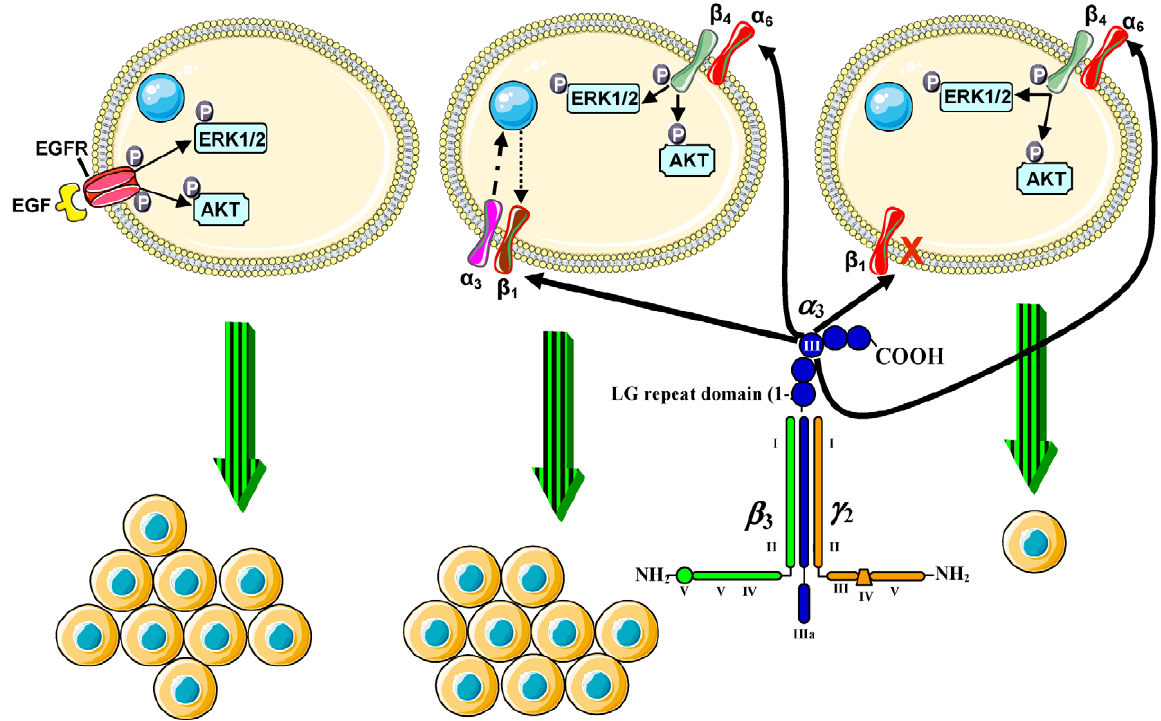
Fig. 1. Schematic representation of HCC tumor